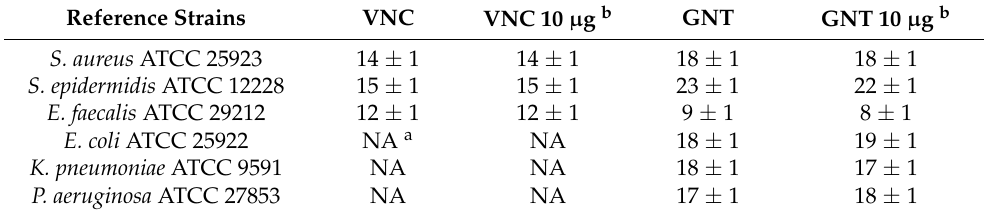
Table 2. Antibacterial activity: diameter of the inhibition zone (in mm) against ATCC reference strains. Reference Strains